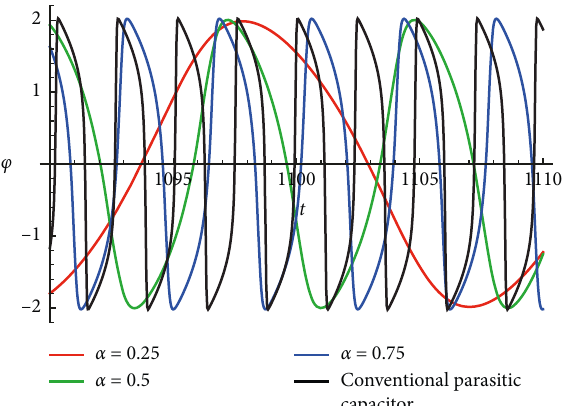
Figure 8: φ vs t of the memristor-inductor circuit with the parasitic fractional capacitor/conventional parasitic capacitor.